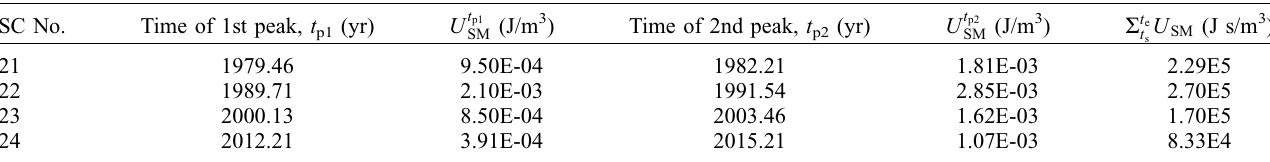
Fig. 1. Variation of (a) monthly smooth sunspot number, (b) solar magnetic field B solar , (c) SMED ð U SM ¼ B 2 vertical dashed-dotted lines indicate the time of start (black), and peak (red) for SCs. Table 2. Occurrence time of first, and second peak in the SMED ( U SM ) and corresponding values of energies are mentioned for SCs 21–24. The SMED gives information about the average magnetic pressure. The integrated U SM for each SC is given in last column. It may be noted that present SC 24 is not yet ended. The value R t e U SM for SC 24 represents the energies contribution till January 2018. t s SC No. Time of 1st peak, t p1